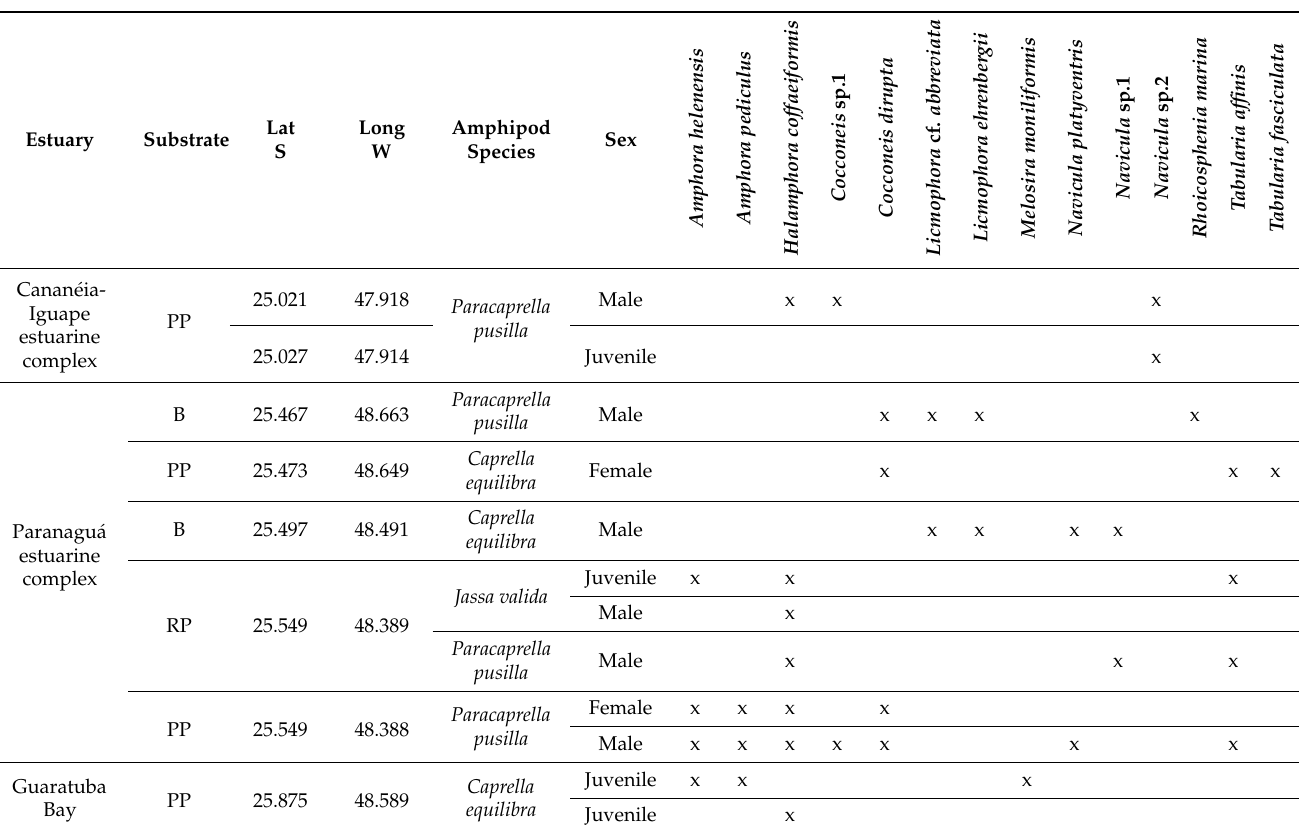
Table 2. Overview of amphipod and diatom species recorded for each analysed sample. Substrates: PP—polyethene plate; B—buoy; RP—rope